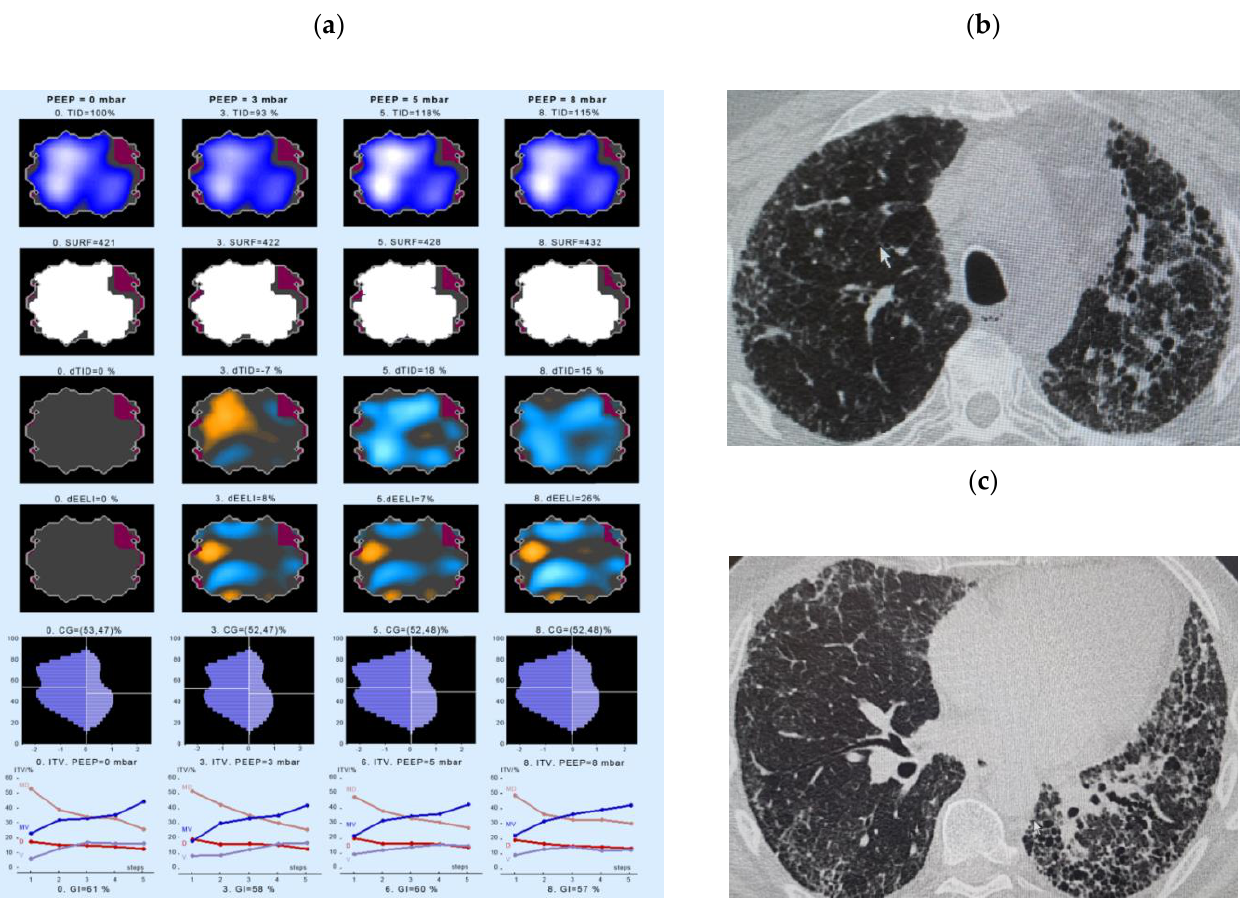
Figure 6. Changes in regional lung ventilation under increasing PEEP in IPF patient #12. Left panel ( a ): Spatial distribution of TID, SURF, dTID, dEELI in the EI tomogram at a PEEP levels of 0 (left), 3 (2nd left), 5 (3rd from left) and 8 cm H 2 O (right column). The lowest panel indicates the intratidal gas distribution (ITV) for four anatomical areas during one respiration. Given are the distribution of ventilation into the ventral (V), dorsal (D), medio-ventral (MV) and medio-dorsal (MD) regions of the lung. The X scale (1–5) shows the entire inspiration, divided into 5 steps. Right panel ( b , c ): The respective high resolution CT picture corresponding to the ROI of EIT measurement is shown. Abbreviations: CG—center of gravity of ventilation distribution; dEELI—difference of end-expiratory lung impedance over time; ITV—intratidal gas distribution; PEEP—positive end-expiratory pressure; SURF—surface of ventilated areas; TID—tidal impedance distribution; dTID—difference of TID over time.